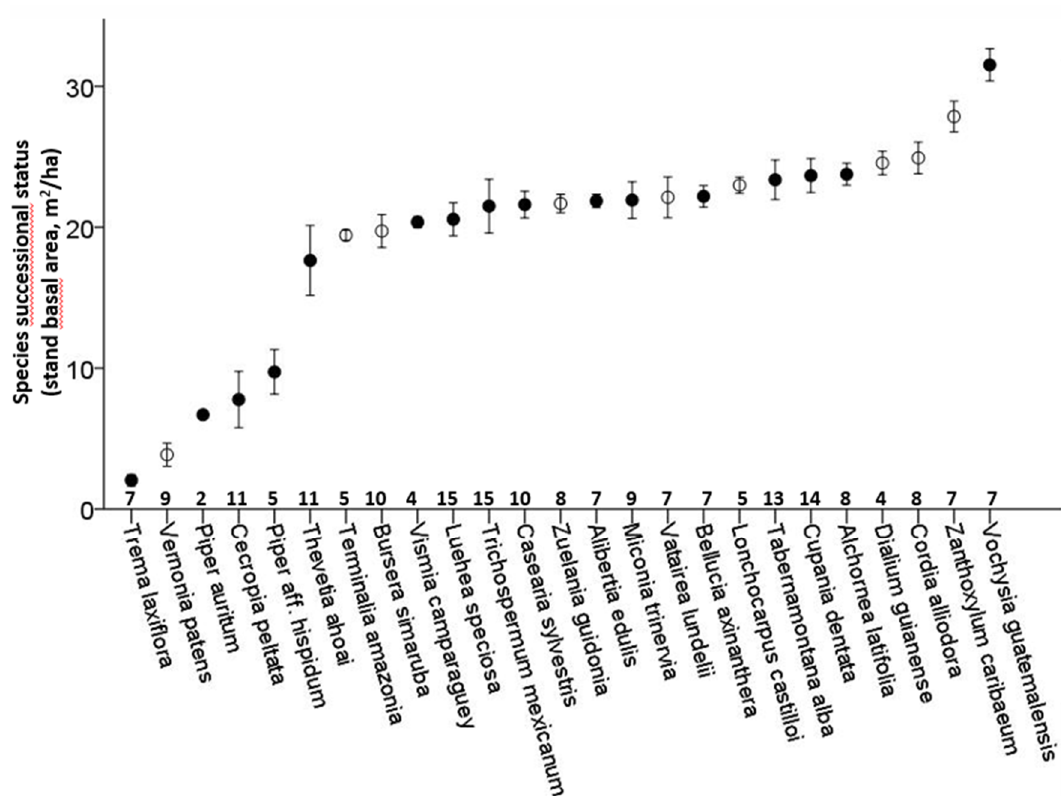
Figure 1. Successional status of 25 tree species of secondary successional tropical rain forest plots in Marqués de Comillas, Chiapas, Mexico. Successional status is defined as the average stand basal area of the plots where the species occurs, weighted for relative abundance (in number of individuals). Species are sorted from early to late successional. Vertical lines indicate standard error of the mean. Open symbols correspond to deciduous species, closed symbols to evergreen species. Numbers on the x -axis indicate the number of plots, out of a total of 15, in which the species is